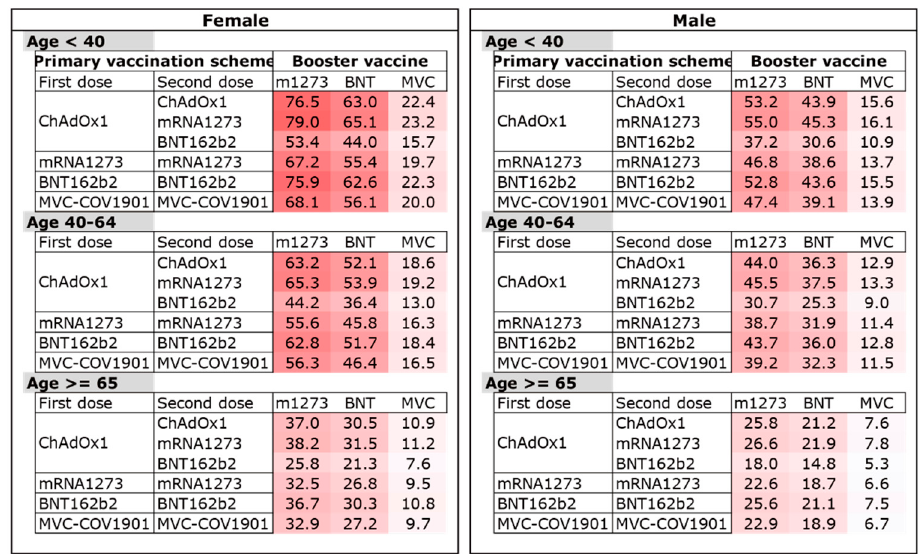
Figure 3. Estimated incidence rates (eIR) of adverse events (AE) among age, sex, primary vaccine and brand of booster vaccine strata. Incidence rates (IR) were estimated using a Poisson regression model and presented as a fraction of 100 respondents. The shading of each cell denotes the IR of each stratum. While a dark color (e.g., dark red) refers to a higher IR, suggesting a higher risk for AE, a light color (e.g., white) refers to a lower rate.